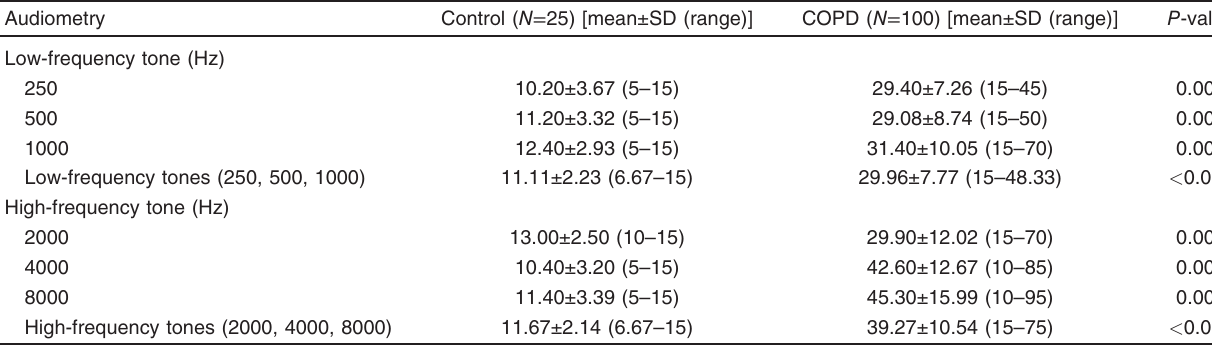
Table 1 Comparison between audiometry in chronic obstructive pulmonary disease patients and controls